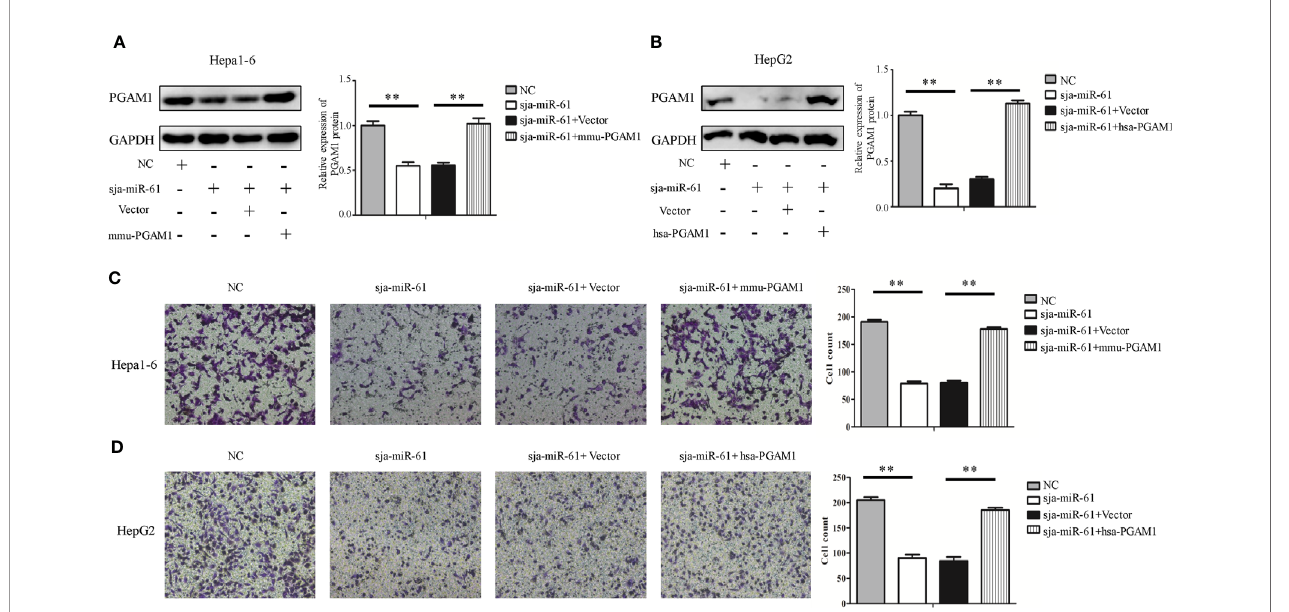
FIGURE 5 | Effect of restoration of PGAM1 expression on the sja-miR-61-mediated effects in vitro . (A – D) Cells were transfected with NC mimics, sja-miR-61 mimics, NC mimics + pcDNA3.1(+) vector, sja-miR-61 mimics + pcDNA3.1(+)-PGAM1, respectively, and 48 h later, the expression of PGAM1 was determined using Western blotting (A, B) . Cell migration was evaluated using transwell inserts without matrigel coating (C, D) . Mean ± SD, n = 3, **p <